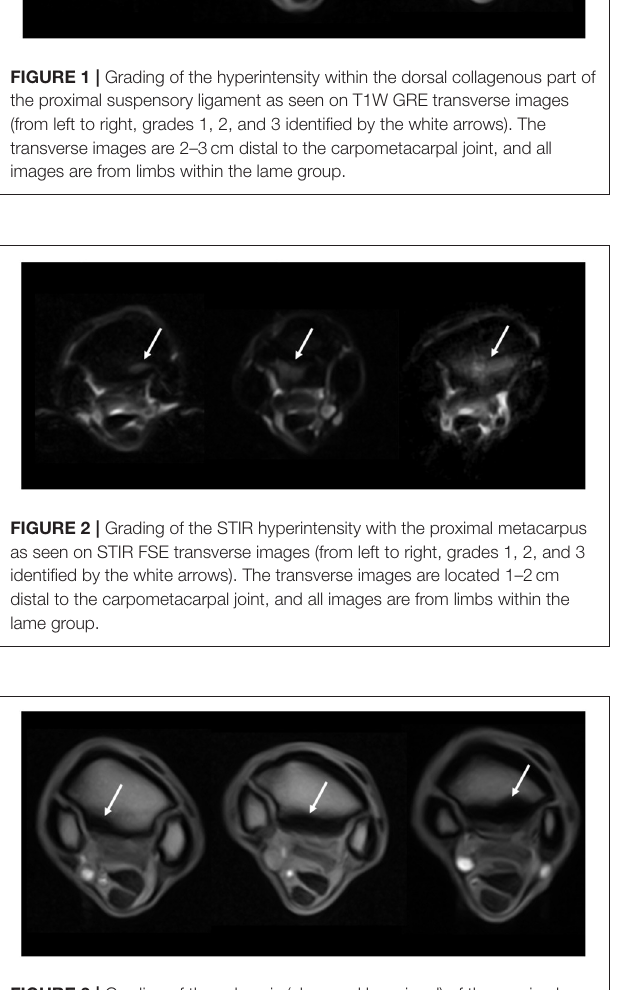
FIGURE 3 | Grading of the sclerosis (abnormal low signal) of the proximal metacarpus as seen on T1W GRE transverse images (from left to right, grades 1, 2, and 3 identified by the white arrows). The transverse images are located 1–2cm distal to the carpometacarpal joint. The left image is from a limb within the control group, and the middle and right images are from limbs within the lame